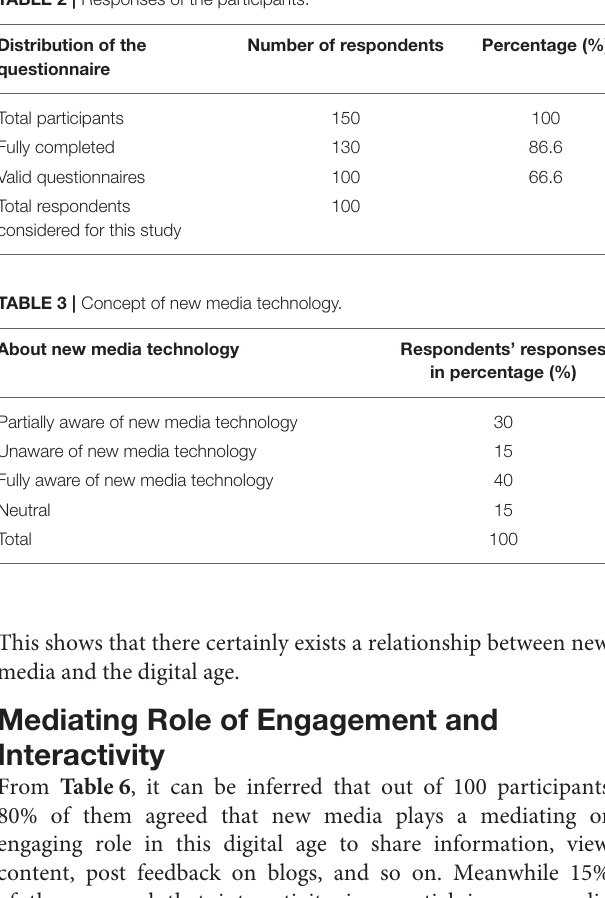
TABLE 2 | Responses of the participants.